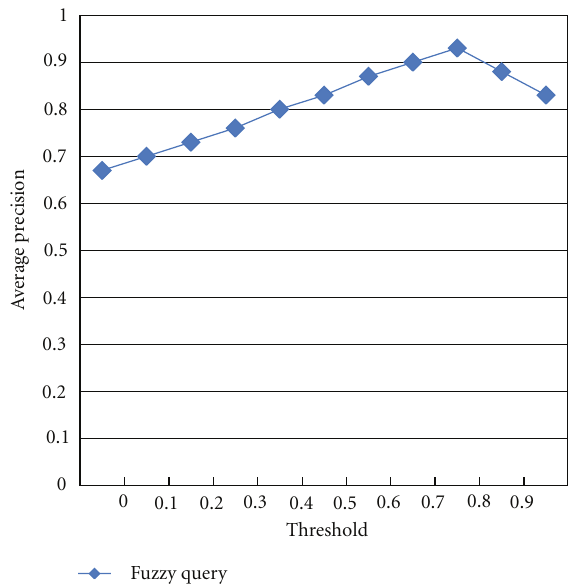
Figure 4: The average precision plot for di ff erent fuzzy query’s threshold limits.